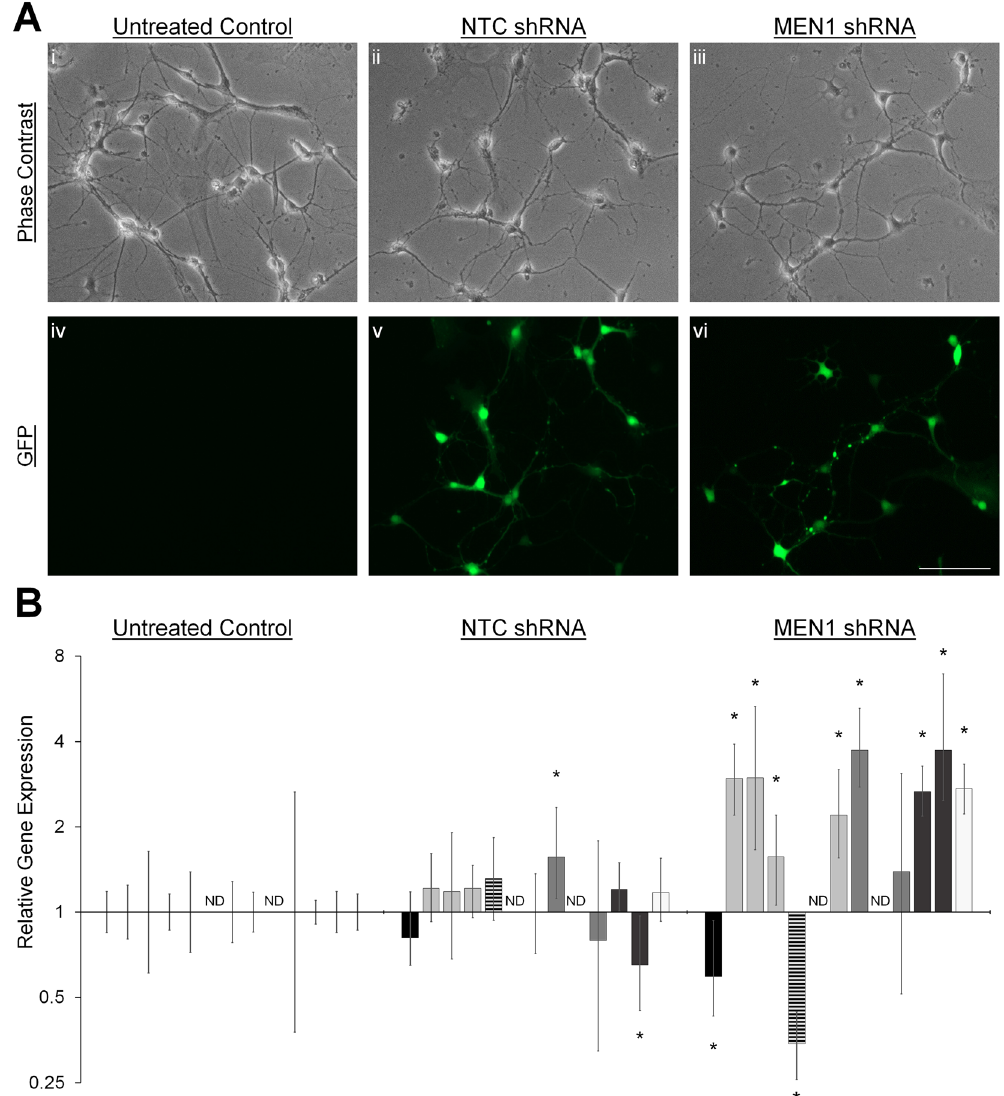
Figure 4. Menin mediates subunit-specific transcriptional regulation of nAChR α 5. ( A ) Live cell phase contrast ( i-iii ) and GFP fluorescence ( iv-vi ) images of untreated control (i,iv), NTC shRNA (ii,v), and MEN1 shRNA (iii,vi) lentivirus transduced hippocampal cultures at DIV 7 (n = 18 images, 6 independent samples each, representative images). Scale bar, 100 μ m. ( B ) Summary data, fold change gene expression in hippocampal cultures at DIV 7, relative to untreated control, determined by qPCR (n = 6, 2 independent experiments each, triplicate replicates). MEN1 knockdown reduces nAChR α 5 expression. ND, qPCR signal not detected. * Statistical significance (pair wise fixed reallocation randomization test), P < 0.05–0.001. See also Table